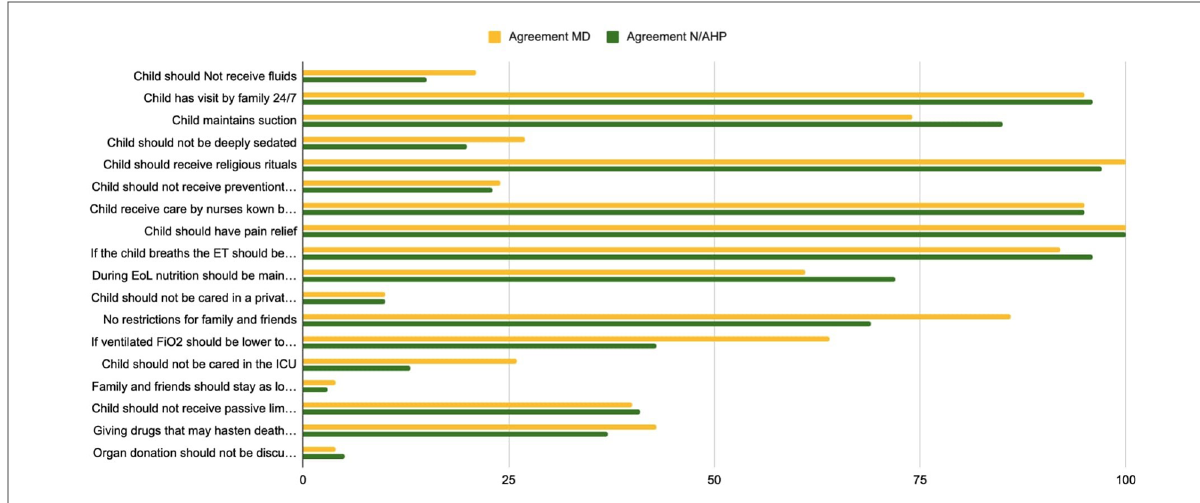
FIGURE 7 Questions 31 – 48. End of Life (EoL)